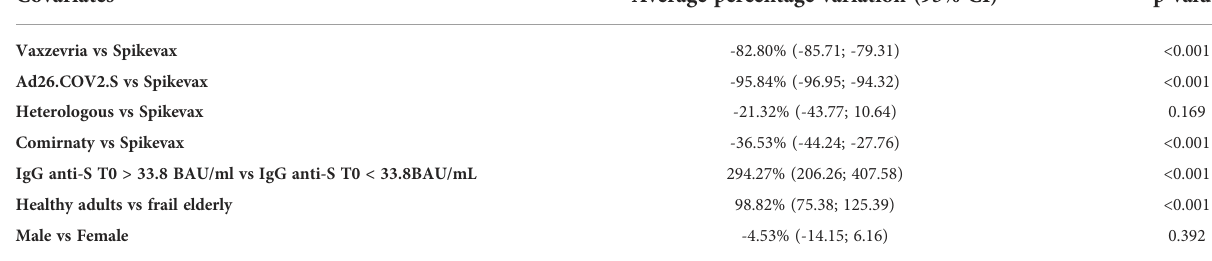
TABLE 3 Average percentage variation of the GMT at T1 with respect to type of vaccine, age group, the response at T0 and sex and 95% con fi dence intervals, obtained as the exponential of the estimated coef fi cient of the log-linear regression model minus 1. Covariates